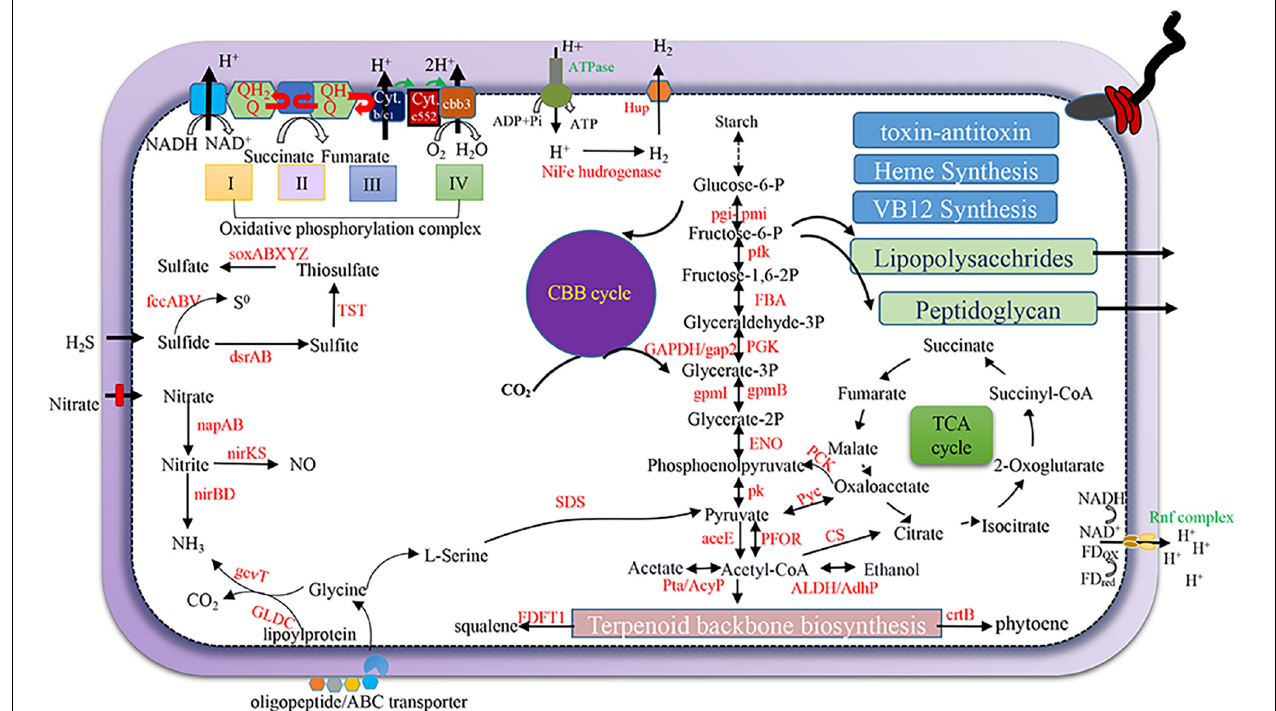
FIGURE 7 | Schematic metabolism of Thiohalomonadales (sulfur oxidizing bacteria) SOB. The metabolic pathways were predicted and depicted based on gene annotation of high-quality MAGs of Thiohalomonadales against KEGG and National Center for Biotechnology Information (NCBI)_nr